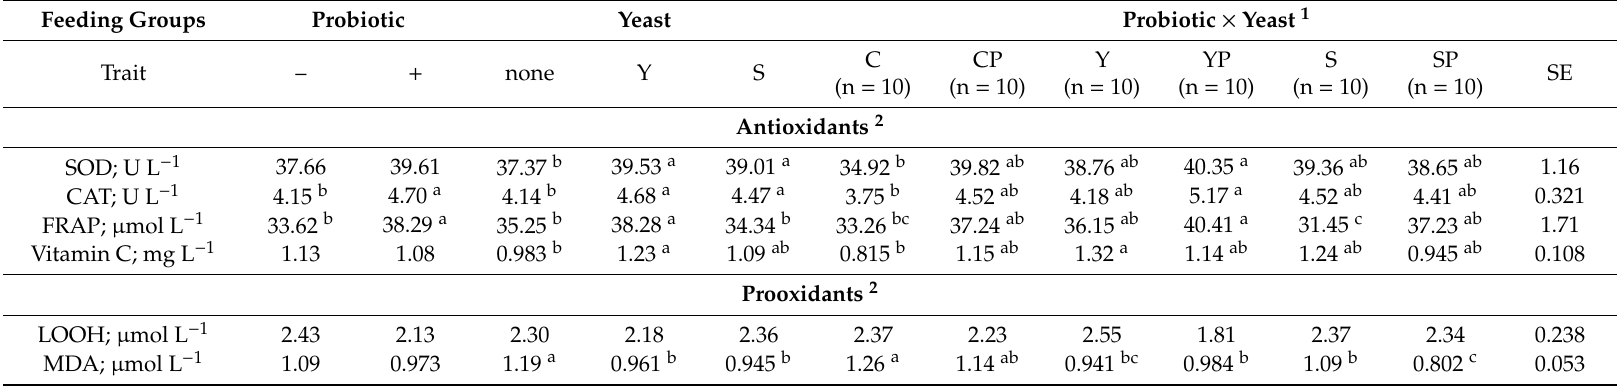
Table 2. Results of statistical analysis of pro- and antioxidant blood plasma parameters in turkey hens. Feeding Groups